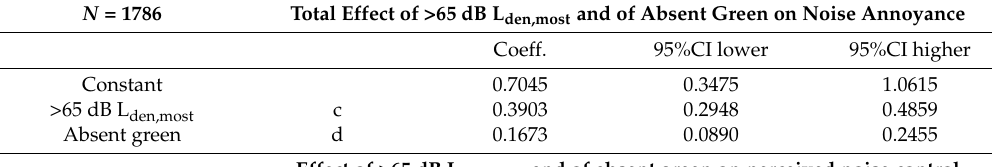
Table 7. Association of exposure to road traffic noise (>65 dB L den,most ) and absent dwelling-related green with perceived noise control and noise annoyance 1